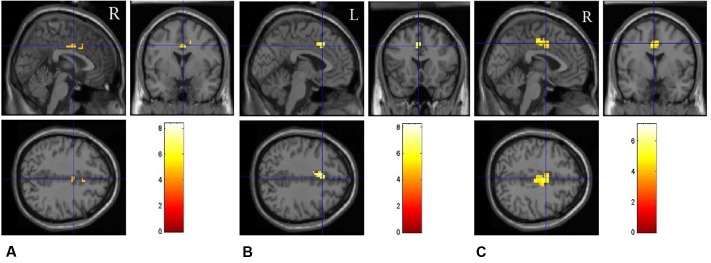
Brain regions involved in task switching in different emotional conditions. The fMRI results are shown separately for the neutral (A), positive (B), and negative (C) emotional conditions, respectively.